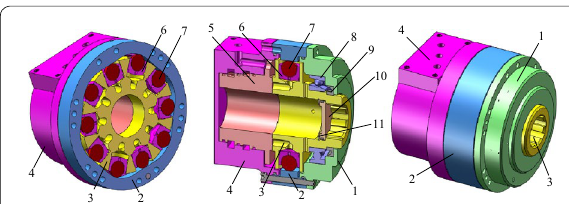
Figure 1 Structure of seawater hydraulic motor with low speed high torque. 1. Front end housing; 2. Stator; 3. Rotor; 4. Rear housing; 5.